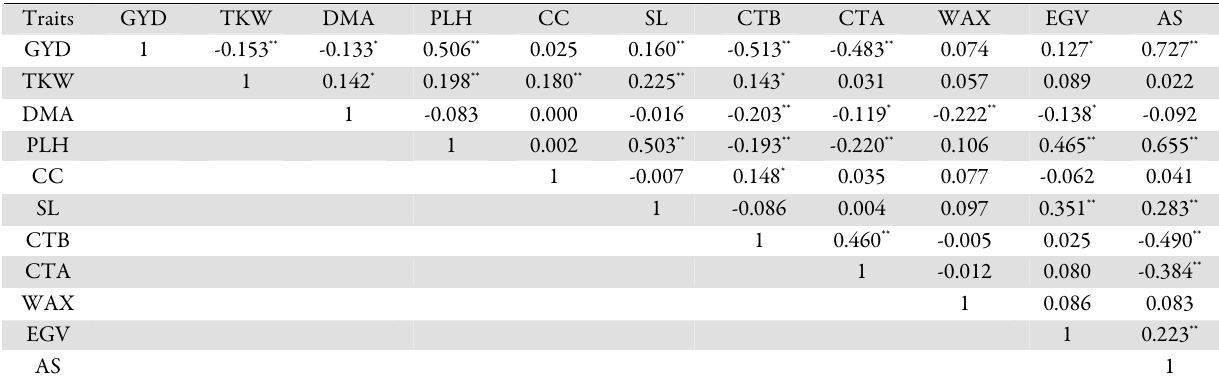
GYD: grain yield; TKW: thousand kernel weight; DMA: days to physiological maturity; PLH: plant height; CC: chlorophyll content; SL: spike length; CTB: canopy temperature 10 day before anthesis; CTA: canopy temperature at anthesis; WAX: leaf waxiness; EGV: early growth vigor; AS: agronomic